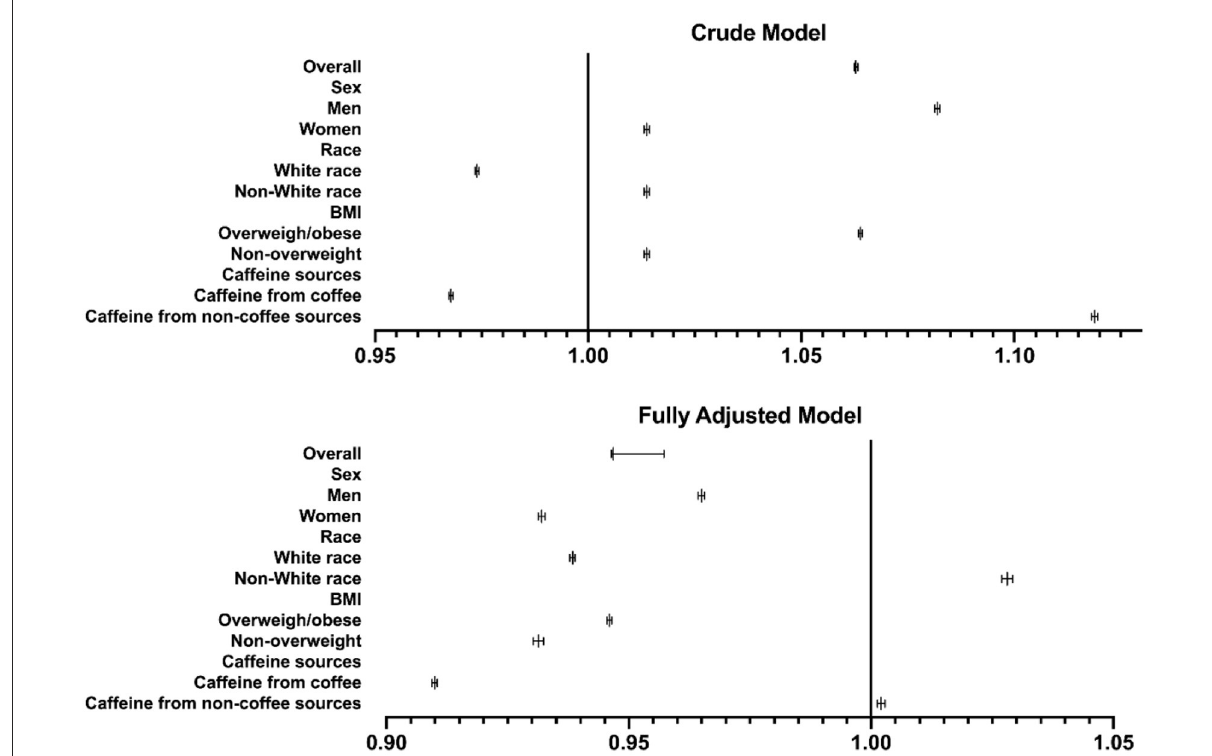
FIGURE1 Subgroup analysis. ORs for the association between caffeine intake and kidney stone. The subgroup analyses results of crude model (model 1) and fully adjusted model (model 3). Abscissa represents odds ratios (ORs) and 95% CI (confidence intervals). The figure showed the OR with 95%CI for the trend of risk of kidney stones as the caffeine intake quarte